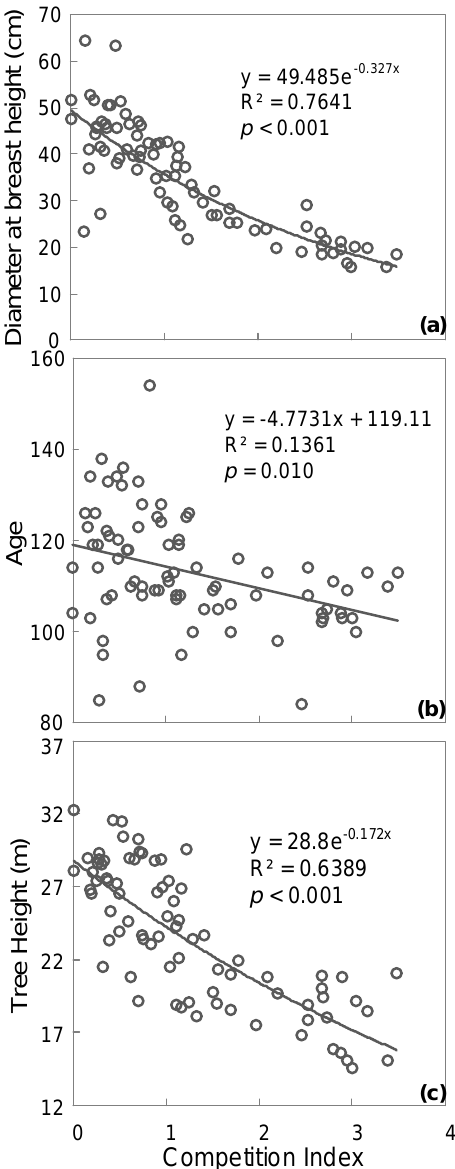
Figure A1. Negative exponential regression ( n = 82) between ( a ) individual tree competition index ( CI ) and diameter at breast height (DBH), ( c ) individual tree CI and tree height. Linear regression ( n = 82) between ( b ) individual tree CI and tree